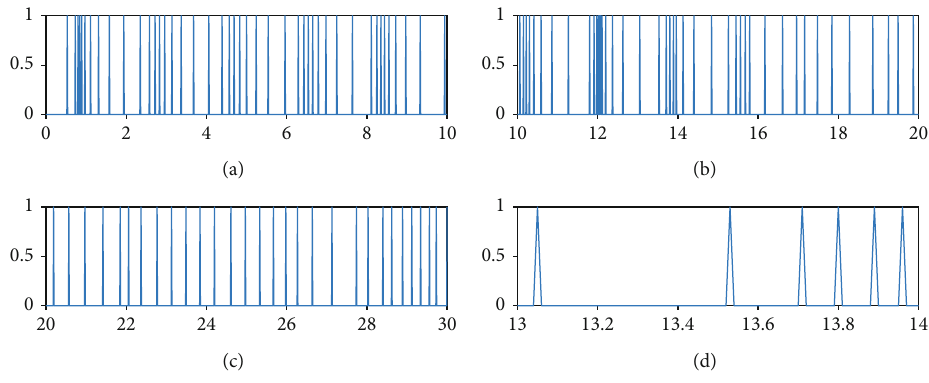
Figure 9: Event-triggered time for